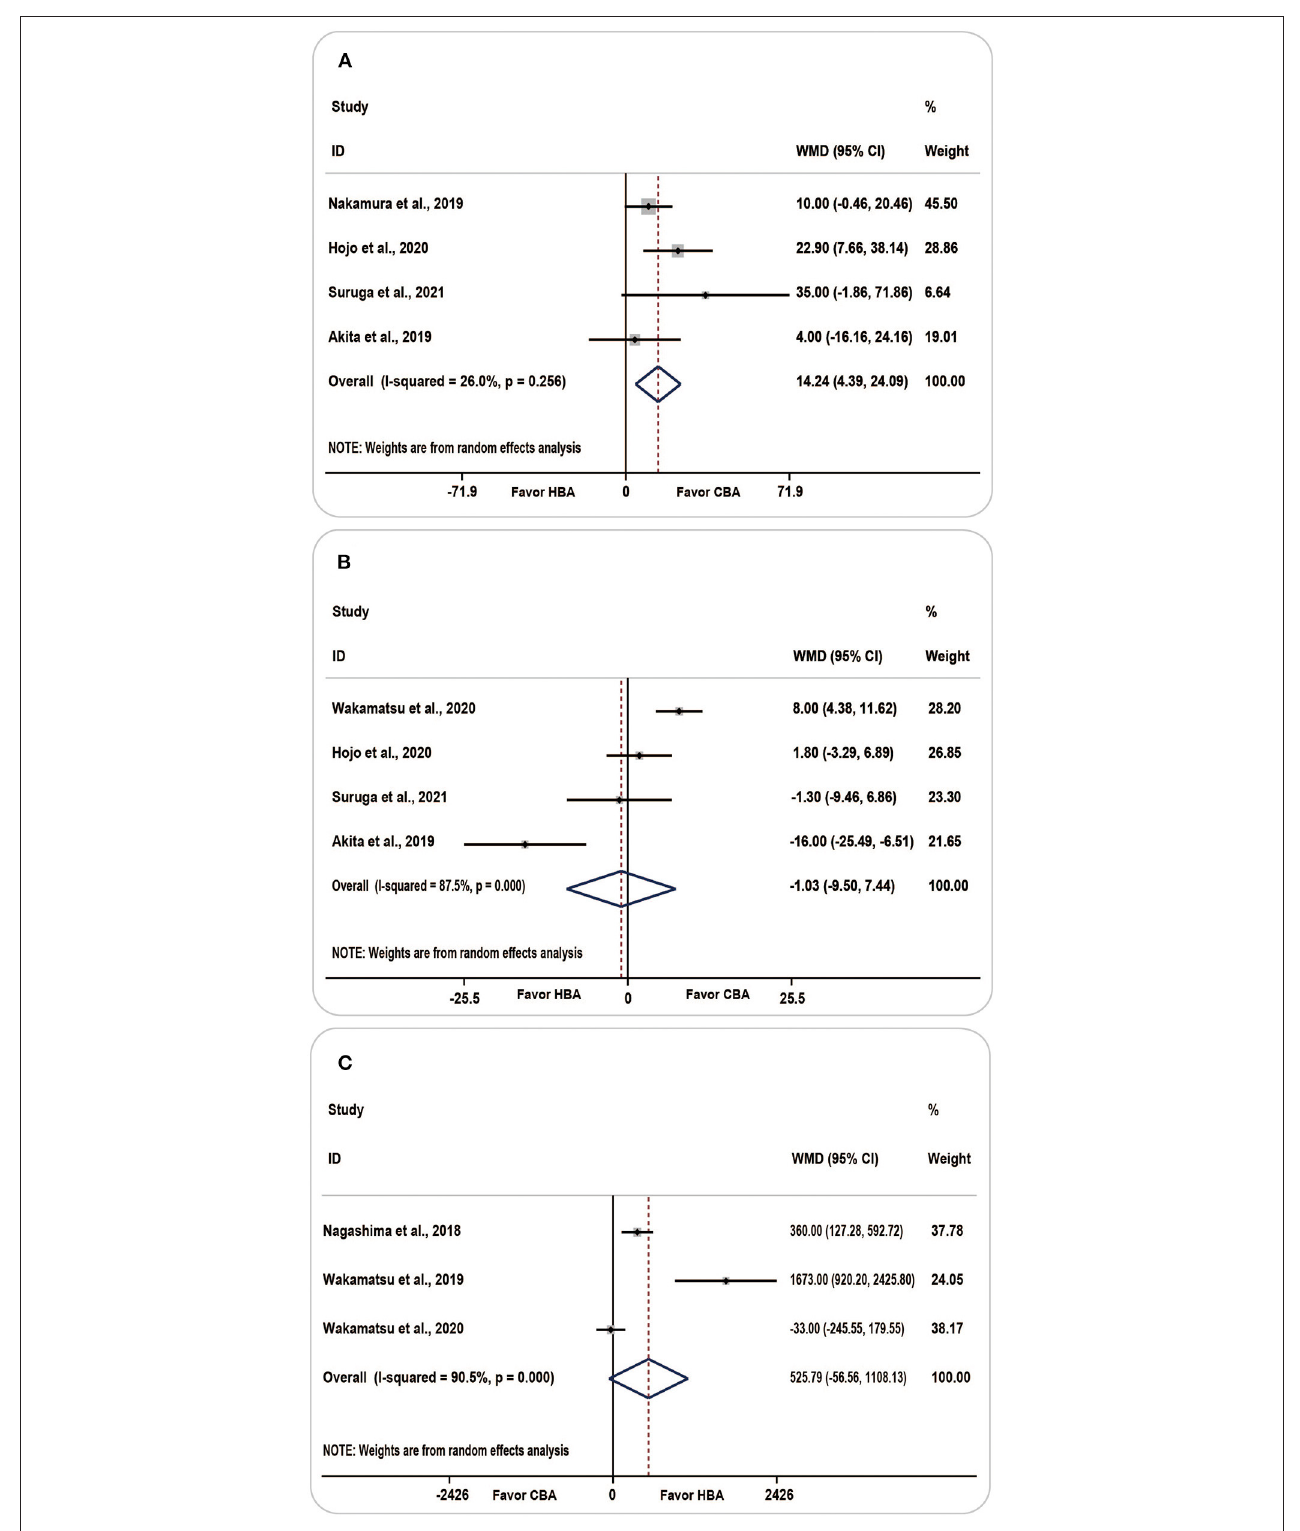
FIGURE 5 | Forest plots showing the association between procedure-related parameters and ablation strategy. (A) Procedure time, (B) fluoroscopy time, (C) total mapping points. CBA, cryoballoon ablation; HBA, hot balloon ablation.